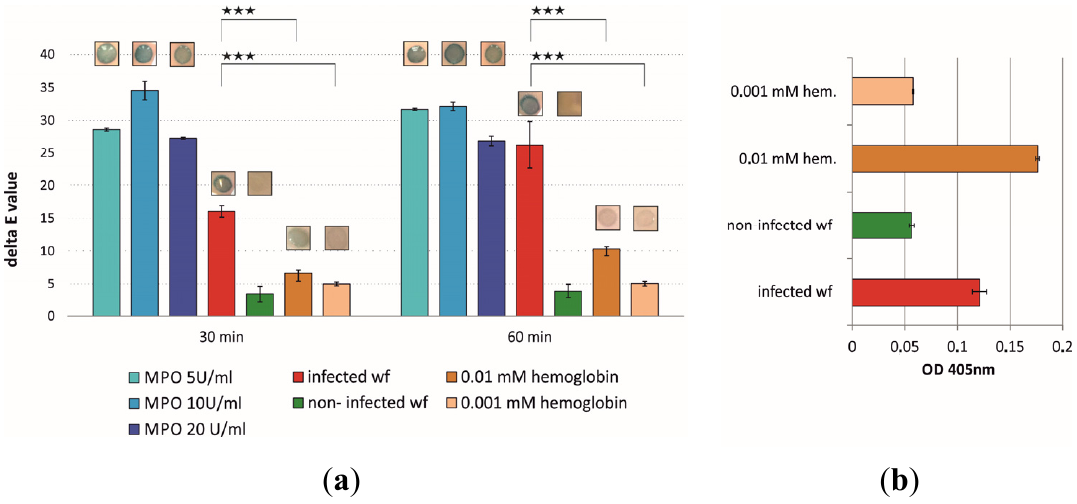
Figure 2. ( a ) Color formation of immobilized alkoxysilane-derivatized Fast Blue RR upon incubation with MPO and wound fluids: alkoxysilane-derivatized Fast Blue RR was polymerized and the resulting enzyme-responsive siloxane layer incubated with different enzyme activities of pure MPO, infected and non-infected wound fluids as well as different concentrations of hemoglobin over a time period of 30 min and 60 min. The blue color formation upon conversion of the substrate was quantified with a ColorLite sph850 spectrophotometer and is given as in delta E values. Two-sample t-tests assuming equal variances were performed, p -values equal or less than 0.001 were considered as significant ( *** ). ( b ) The hemoglobin concentration of the infected and non-infected wound fluid was determined prior to the immobilization